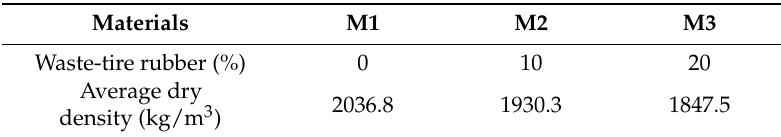
Table 1. Composition and density of mixtures.